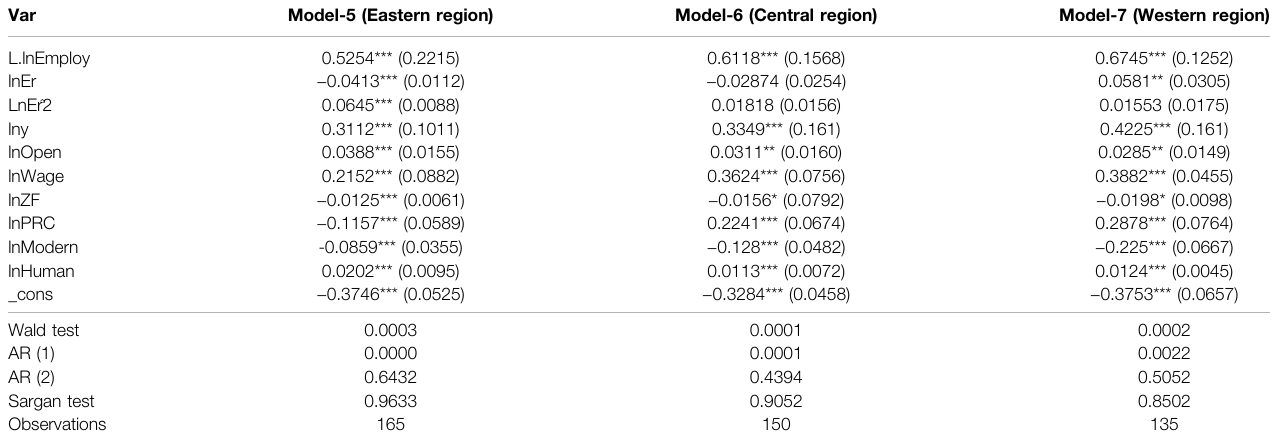
TABLE 4 | Analysis of state heterogeneity of employment effect of carbon emission regulation (Explained variable: lnEmploy; SYS-GMM estimation). Var